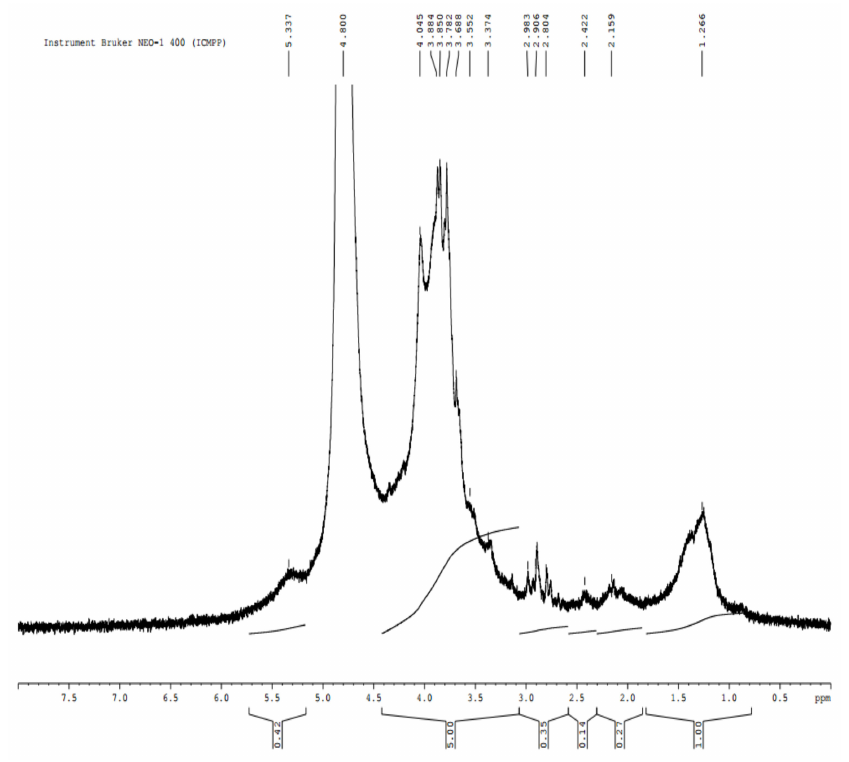
Figure 3. NMR spectrum of fucoidan extract separated from Fucus spiralis